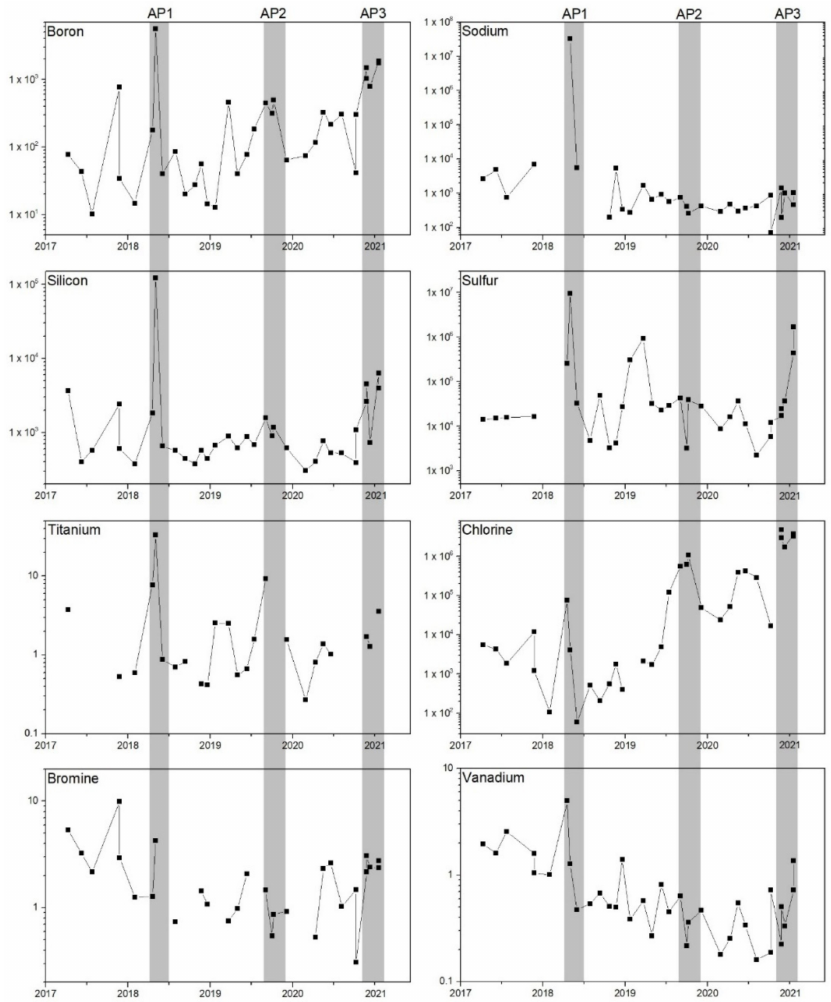
Figure 3. Concentration (in ppb) of selected major and trace elements in condensate samples at La Soufriere volcano. It is important to note that higher concentrations were reached within anomalous periods (grey areas described in Section 4.2). Missing data points (i.e., bromine) correspond to concentrations below the detection limit or high RSD > 50% (Supplementary Material